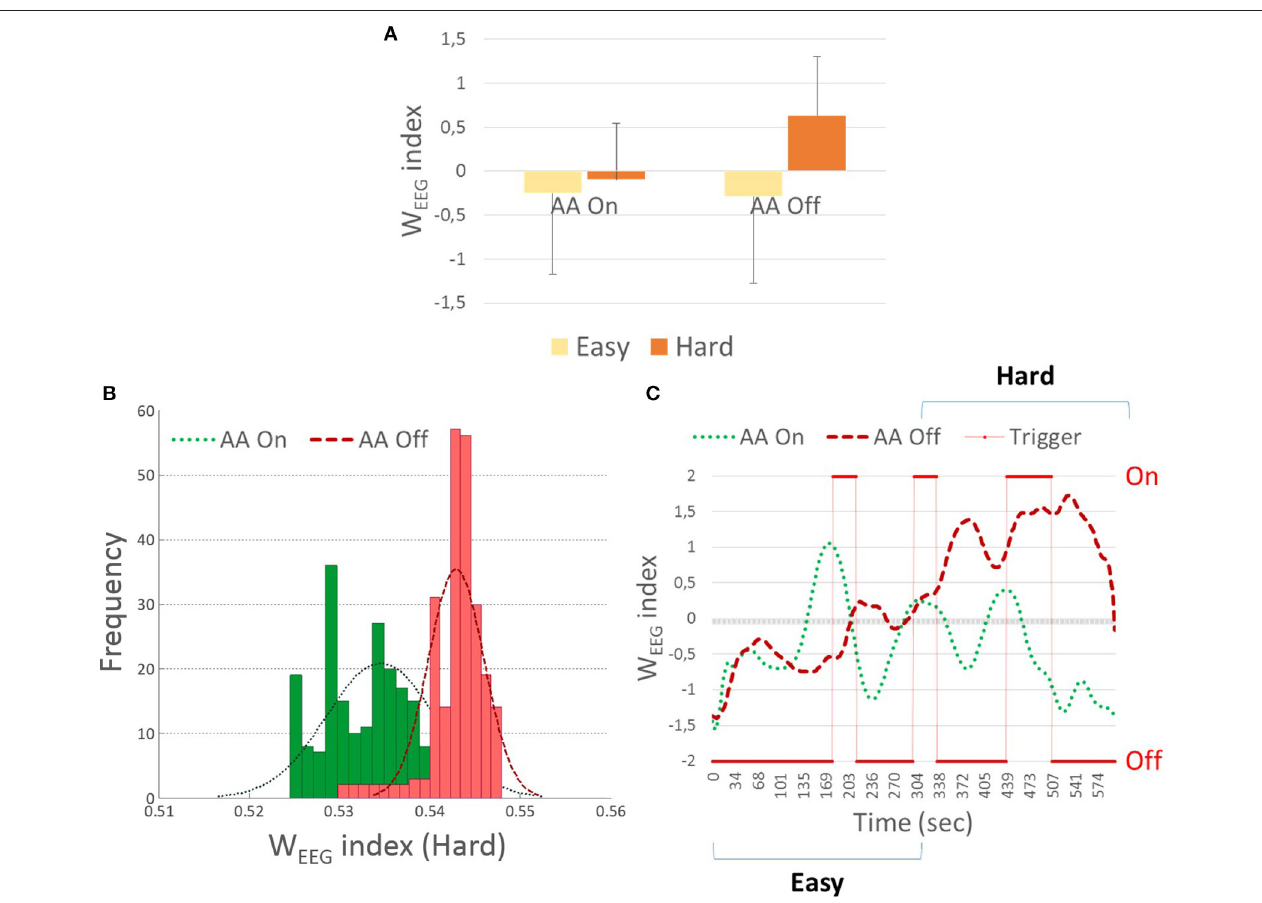
FIGURE 5 | (A) Vertical bars of the neurophysiological workload index distributions (W EEG ) related to the Easy and the Hard slots, during the conditions AA On and AA Off . (B) Figure shows the shape of the W EEG distributions related to the Hard slot, for both the two conditions ( AA On/Off ). (C) Figure shows the time course of the W EEG index related to the Easy and Hard slots, in both the two conditions ( AA On/Off ) together with the AA activation segments (Trigger) for a representative subject. The figure suggests that when the AA is activated, the W EEG index related to the AA On condition decreases